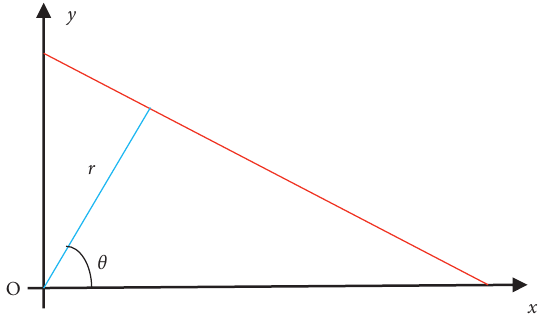
Figure 6: Lines in polar